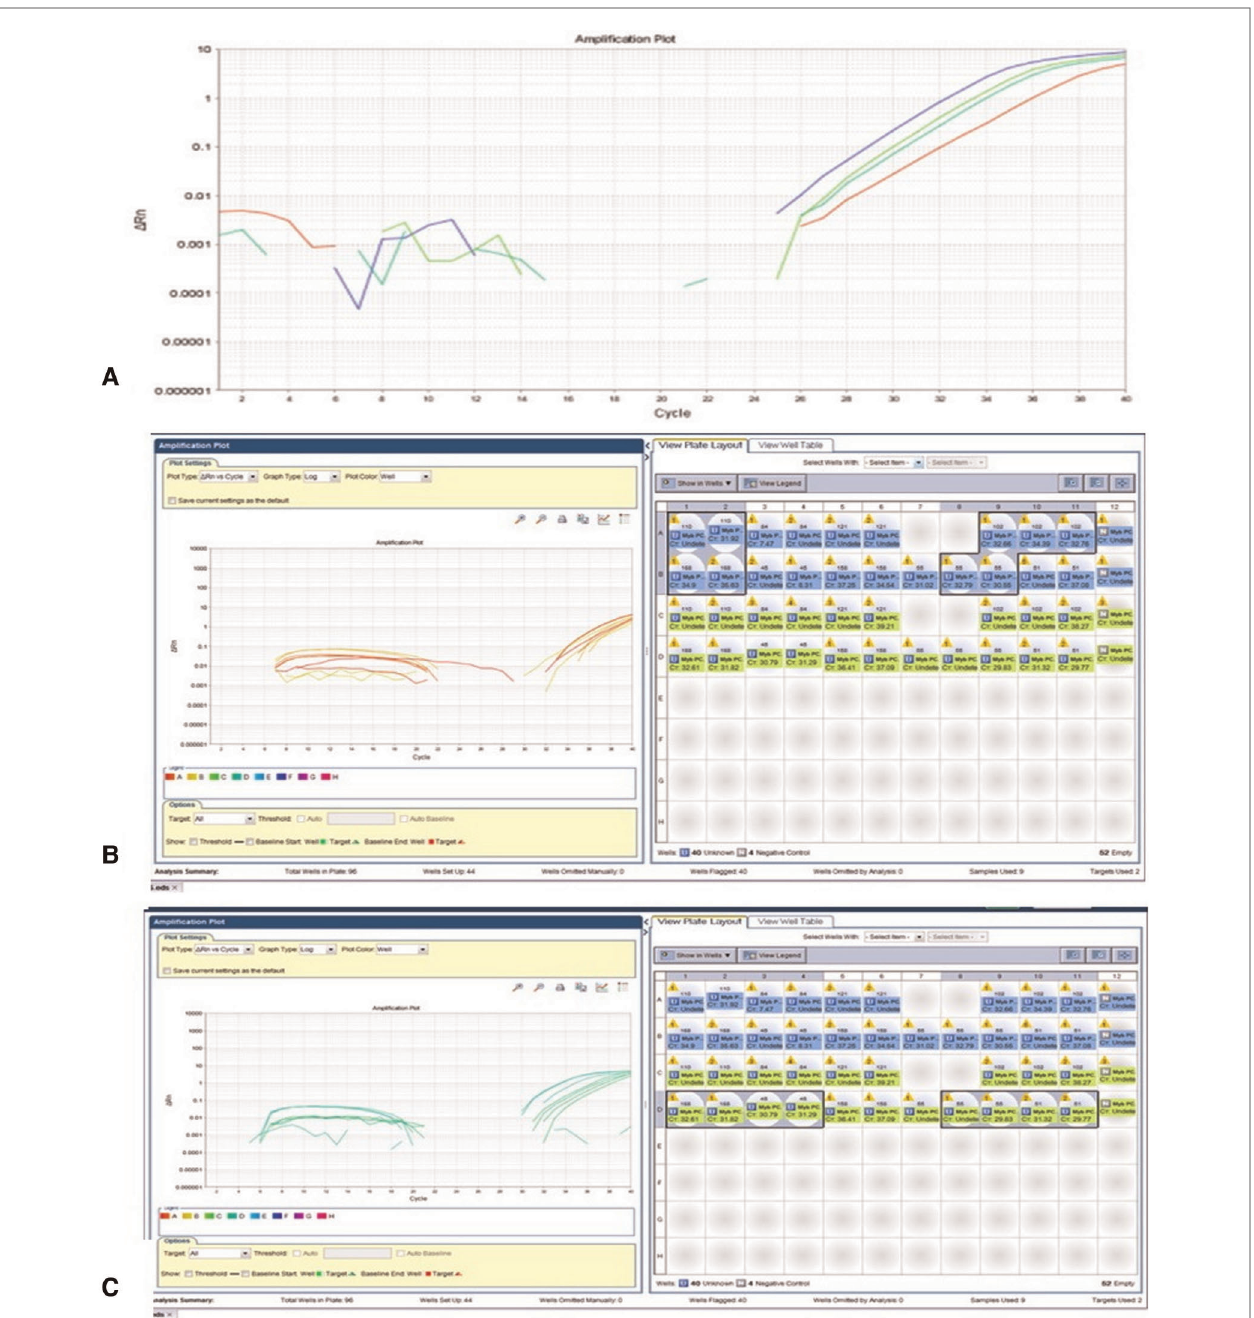
FIGURE 3 | MYB translocation with exon 2 or 3 of PCDHGA1 By RT-PCR. ( A ) As predicted, the product was detected in sample 53 (110) with primers MYB F+R (blue) and PCDHGA1 F+R (upper green); sample 51 showed product in primers MYB F+R combination (lower green) and PCDHGA1 F+R (red). ( B ) RT-PCR results of MYB exon 9 and exon 2 of PCDHGA1. Note 4 positive samples for this translocation 53(110), 55(102) – PMA; 168- oligodendroglioma; 60(55)-PXA. ( C ) RT-PCR results of MYB exon 9 and exon 3 of PCDHGA1. MYB forward & PCDHGA1 reveres show product only in translocation samples. Note 4 positive samples for this translocation (51- DA; 50(45)- ganglioglioma;168 - oligodendroglioma; 60(55) -